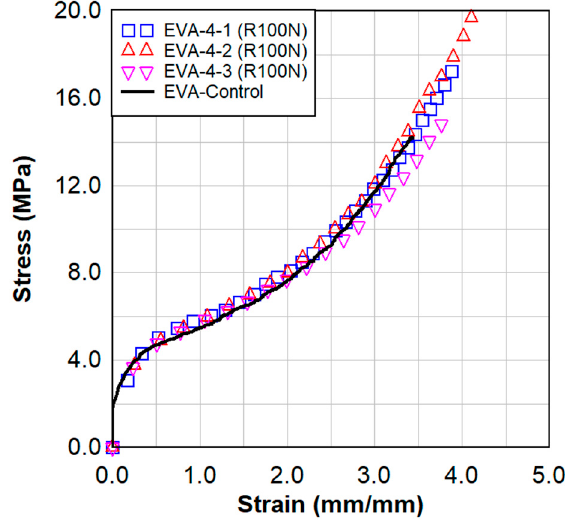
Figure 5. Static testing of EVA − 4 (R100N) specimens, with aluminum-EVA-aluminum configuration, in comparison to the virgin EVA material.